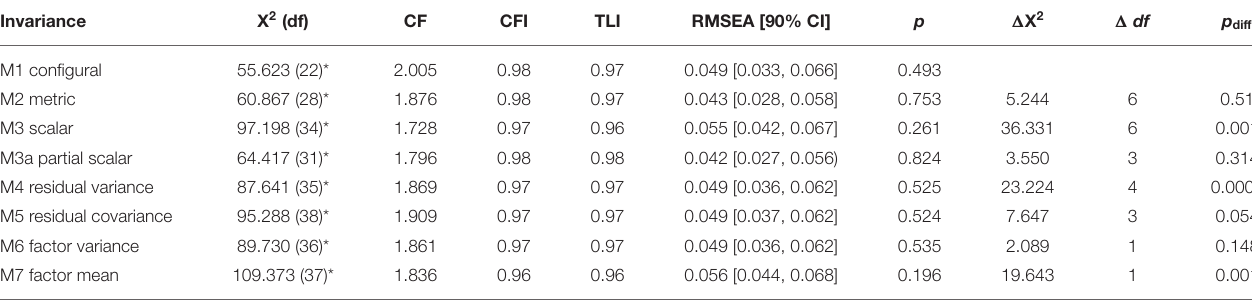
TABLE 6 | Fit statistics for measurement invariance by gender.